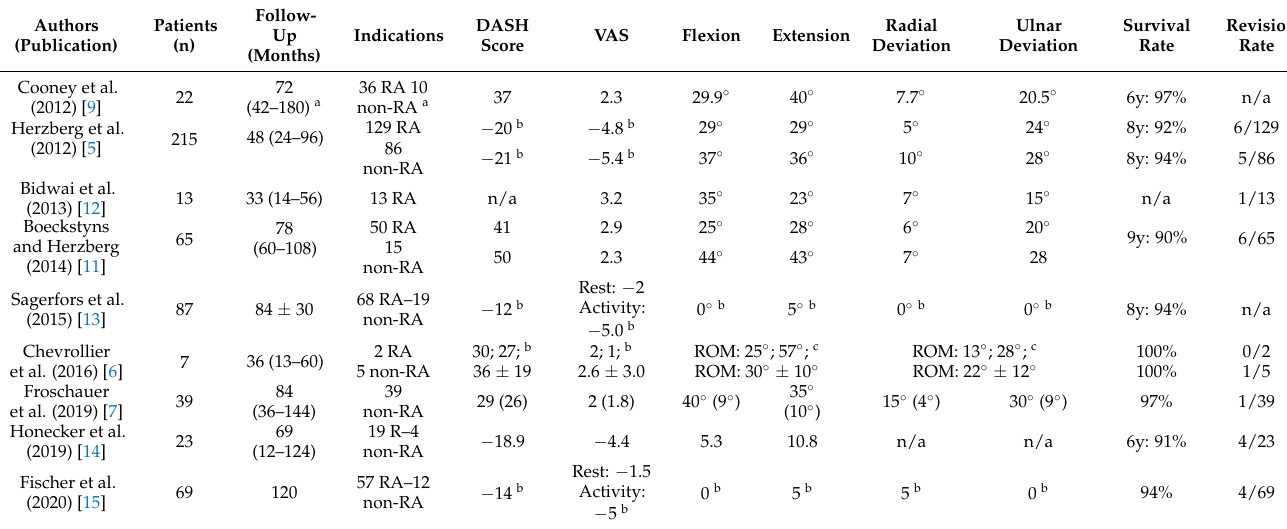
Table 5. Review of the current literature involving all publications reporting about ReMotion